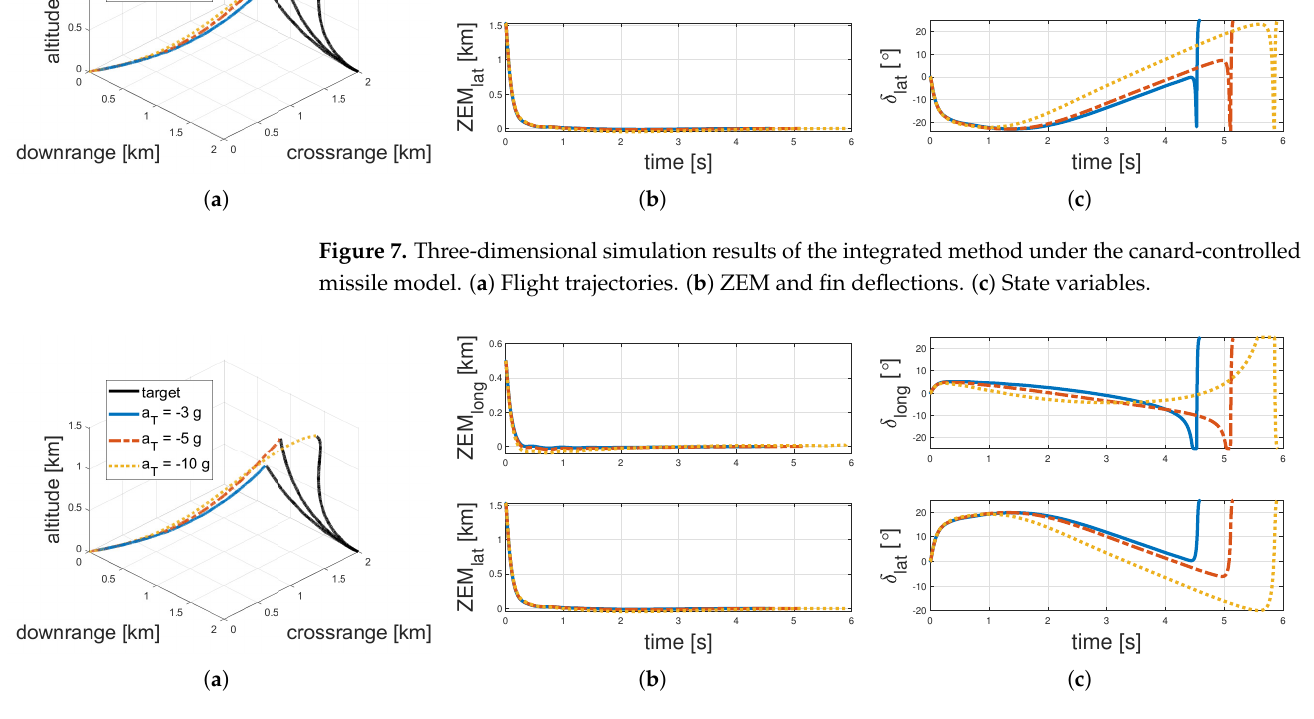
Figure 8. Three-dimensional simulation results of the integrated method under the tail-controlled missile model. ( a ) Flight trajectories. ( b ) ZEM and fin deflections. ( c ) State